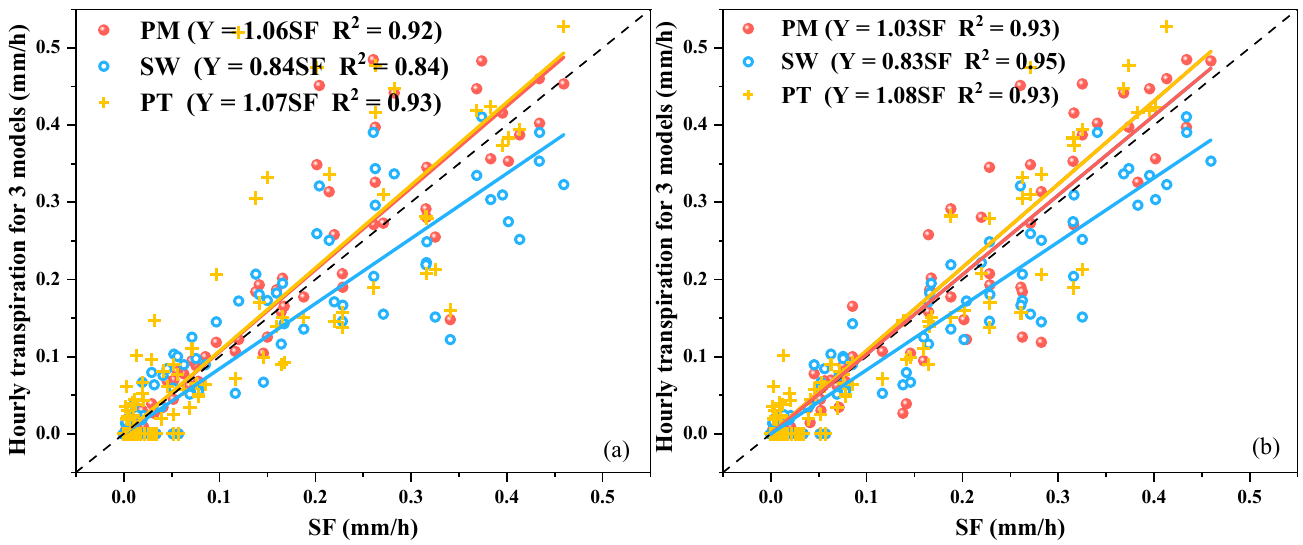
Figure 8. Correlation between simulated hourly Tr and the measured sap flow (SF) when the SF lag time was not considered ( a ) and considered ( b ) during the seven sample days in the 2019 winter season.